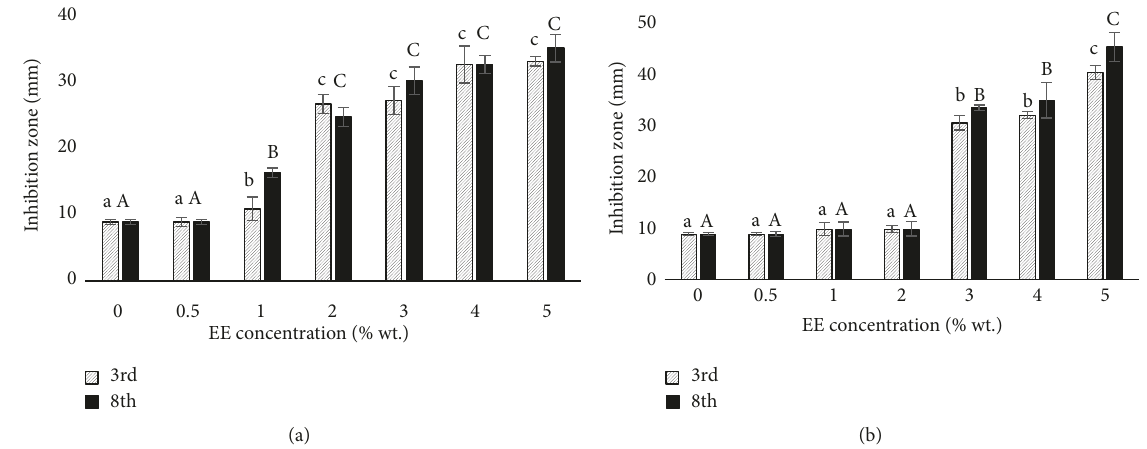
Figure 5: Antimicrobial activity of chitosan films with the oregano EO at days 3 and 8 against fungi (a) Candida albicans and (b) Aspergillus niger . The various lowercase and uppercase letters indicate significant differences ( 𝑃 < 0.05 ) between the films on the 3rd and 8th day subsequent to the day they were dried, respectively.